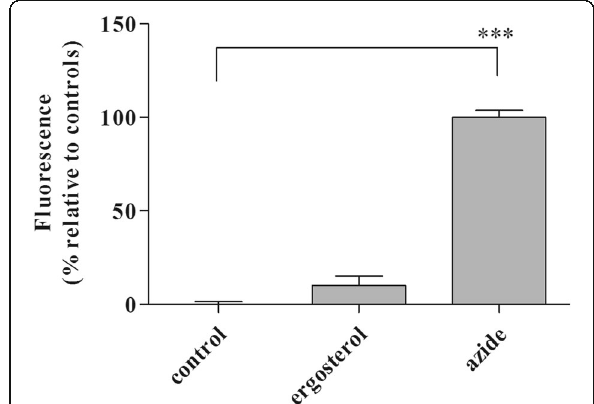
Fig. 4 Effect of ergosterol in the ROS production of trypomastigotes. Fluorescence of H 2 DCF-DA was measured after 60 min of incubation. Fluorescence was quantified by calculating the mean percentage of untreated (0%) and sodium azide-treated (100%) trypomastigotes. ***( p <0.001). A representative assay is